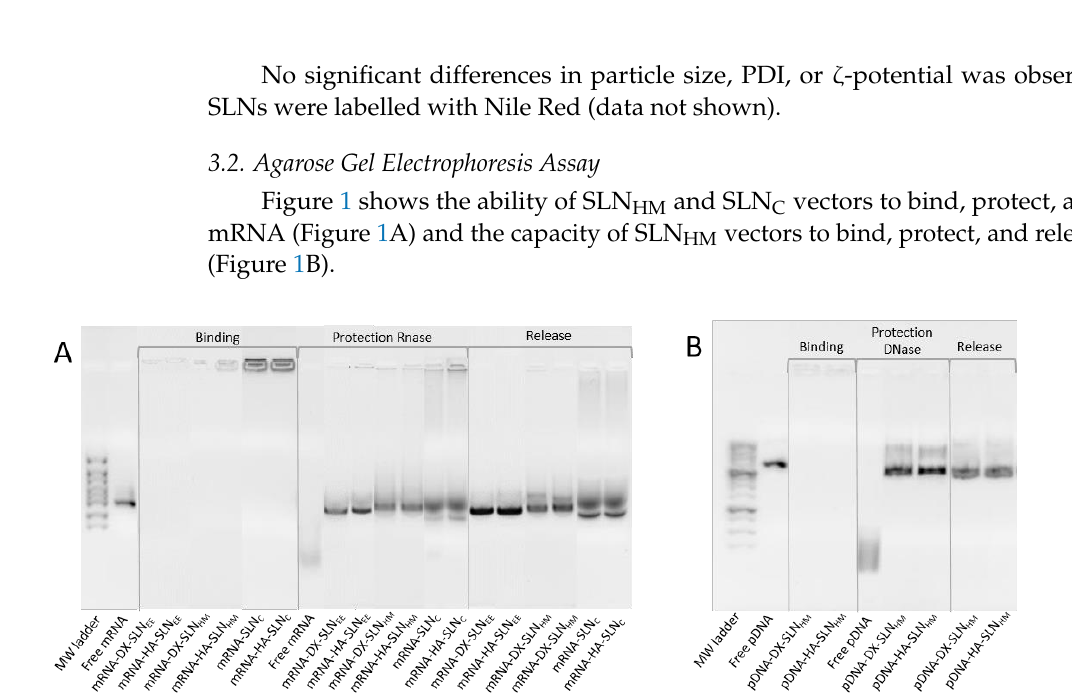
Figure 1. Binding, protection and release capacity of mRNA- and pDNA-based vectors. ( A ) mRNA-SLN HM and mRNA-SLN C ; ( B ) pDNA-SLN HM . DX: dextran; HA: hyaluronic acid; SLN EE : solid lipid nanoparticle prepared by emulsification-evaporation method. SLN HM : solid lipid nanoparticle prepared by hot-melt emulsification method. SLN C : solid lipid nanoparticle prepared by coacervation method.